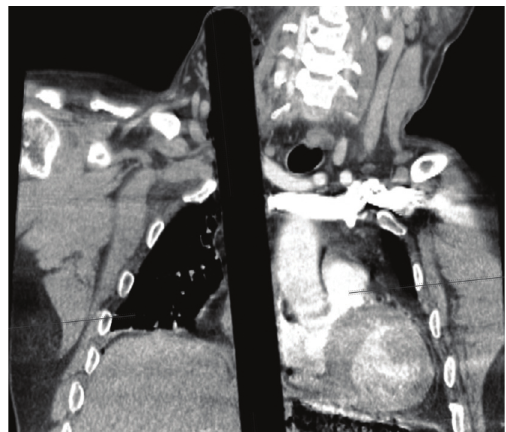
Figure 2: Coronal CT radiograph showing the blunt end of the object extending into the neck.